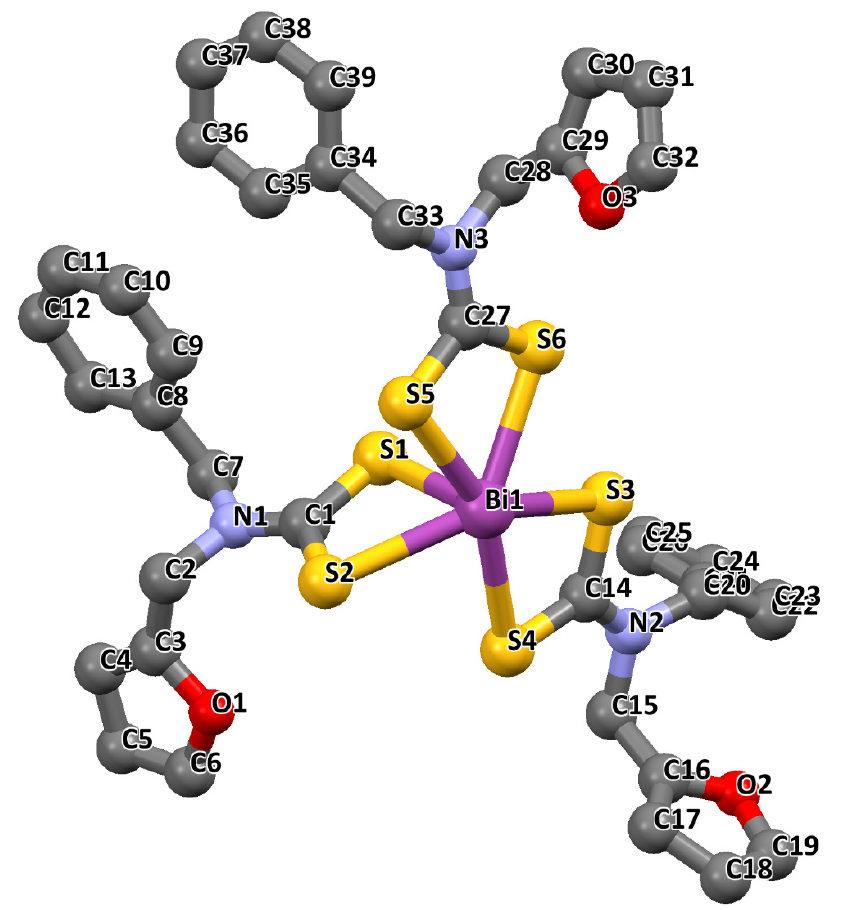
Figure 6. Crystal structure and the labelling scheme of tris( N -furfuryl- N -benzyldithiocarbamato- S , S ′ )bismuth(III) at 40% probability. Redrawn from [61], with permission from Elsevier (copyright 2019).